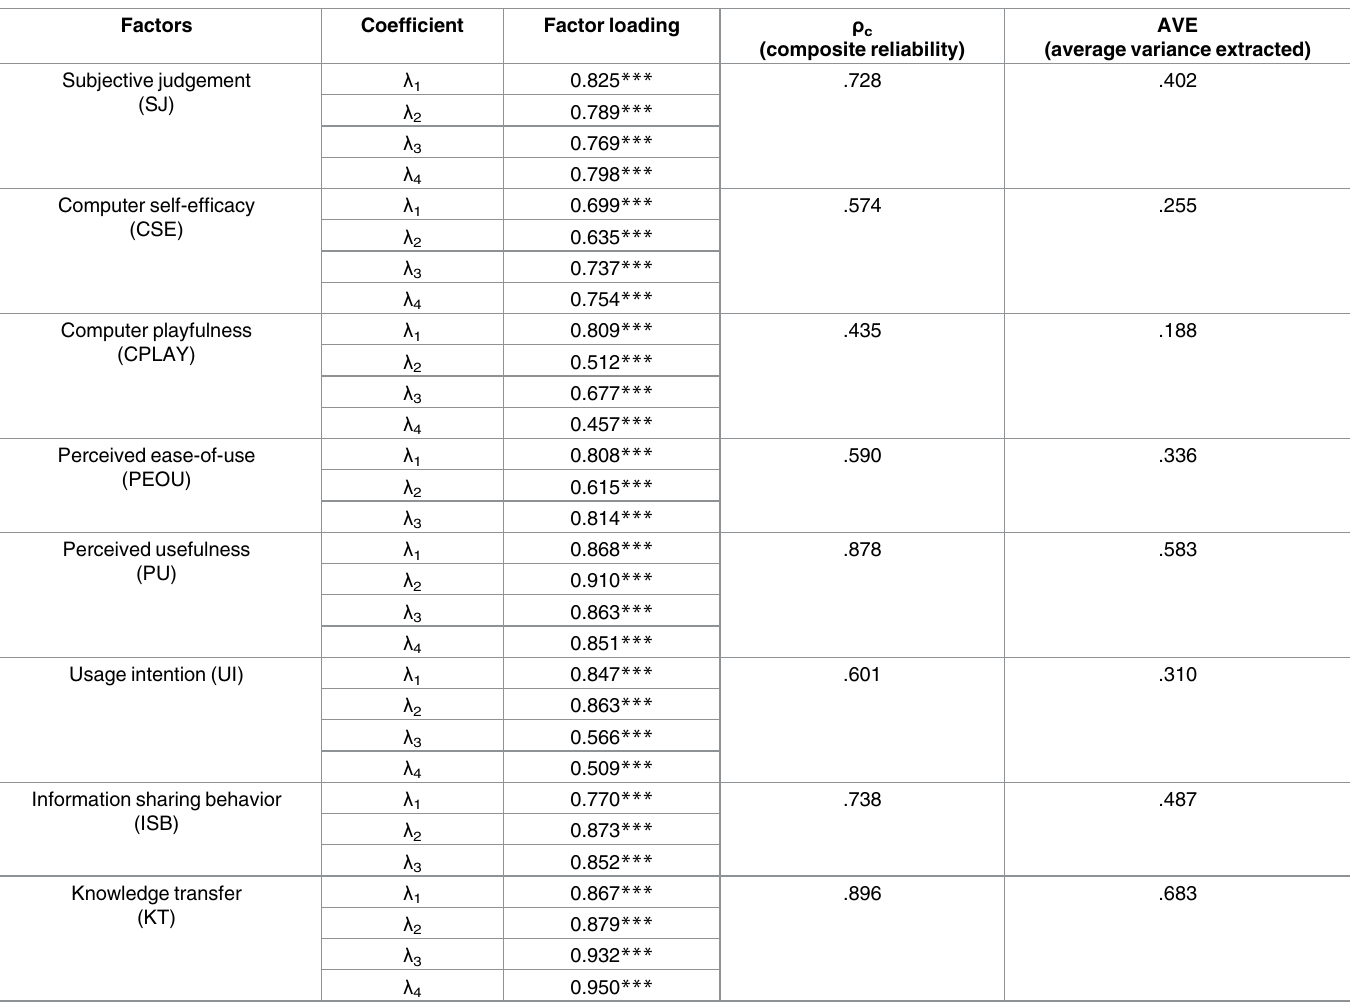
Table 1. Summaryof convergent validity verification